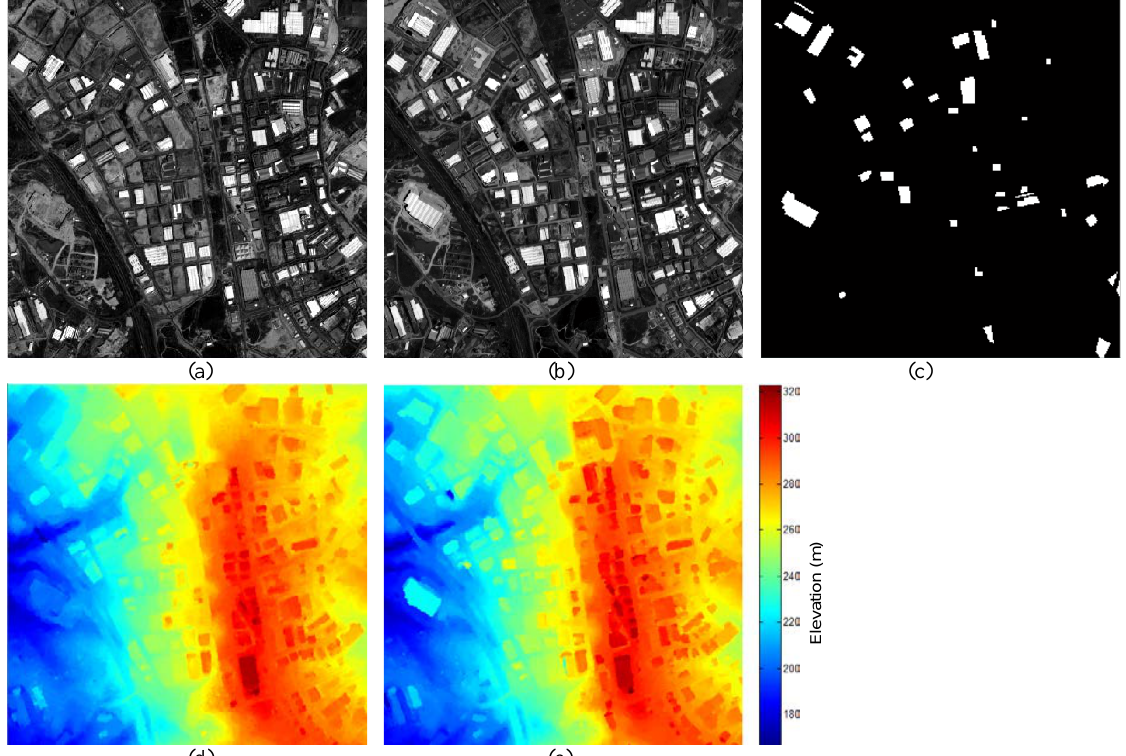
Figure 4. Dataset for Istanbul test area, including orthorectified panchromatic image from date 1 (a) and date 2 (b), DSM from date 1 (c) and date 2